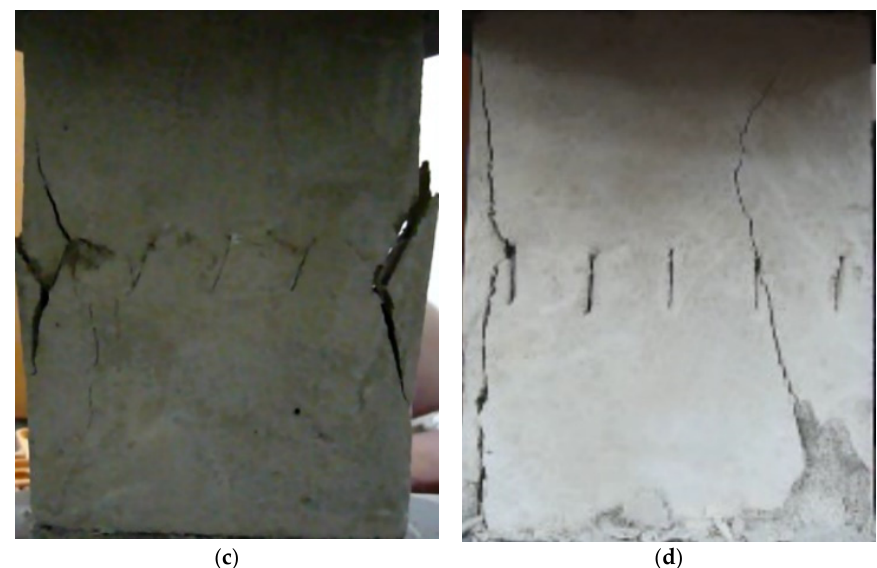
Figure 6. The failure process with 5 cracks. ( a ) 25°; ( b ) 45°; ( c ) 75°; ( d ) 90°.